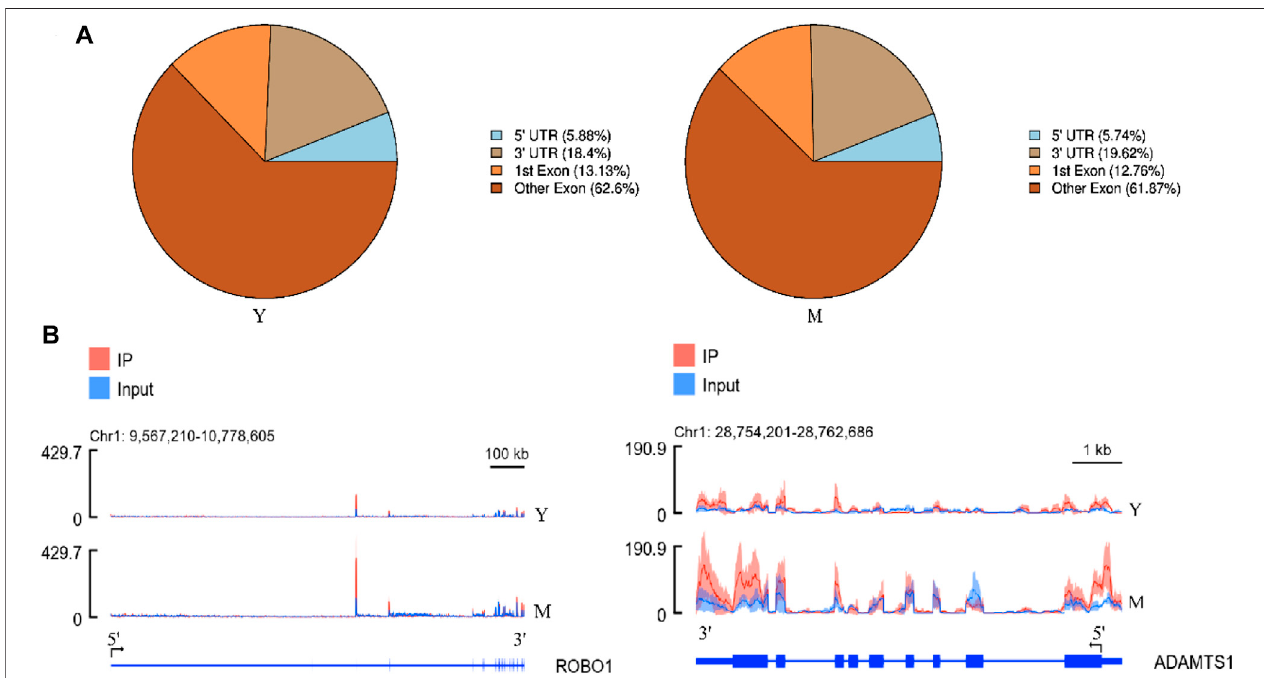
FIGURE 2 | Topological distribution of m6A peaks. (A) , Pie chart showing the peak in gene functional element region annotation. (B) , IGV plot shows directly the peaks in the genes of ROBO1 and ADAMTS1. The peak of ROBO1 was located at the CDS and 3 ′ UTR regions, and the peak of ADAMTS1 was located at the 3 ′ UTR, the CDS, and the 5 ′ UTR